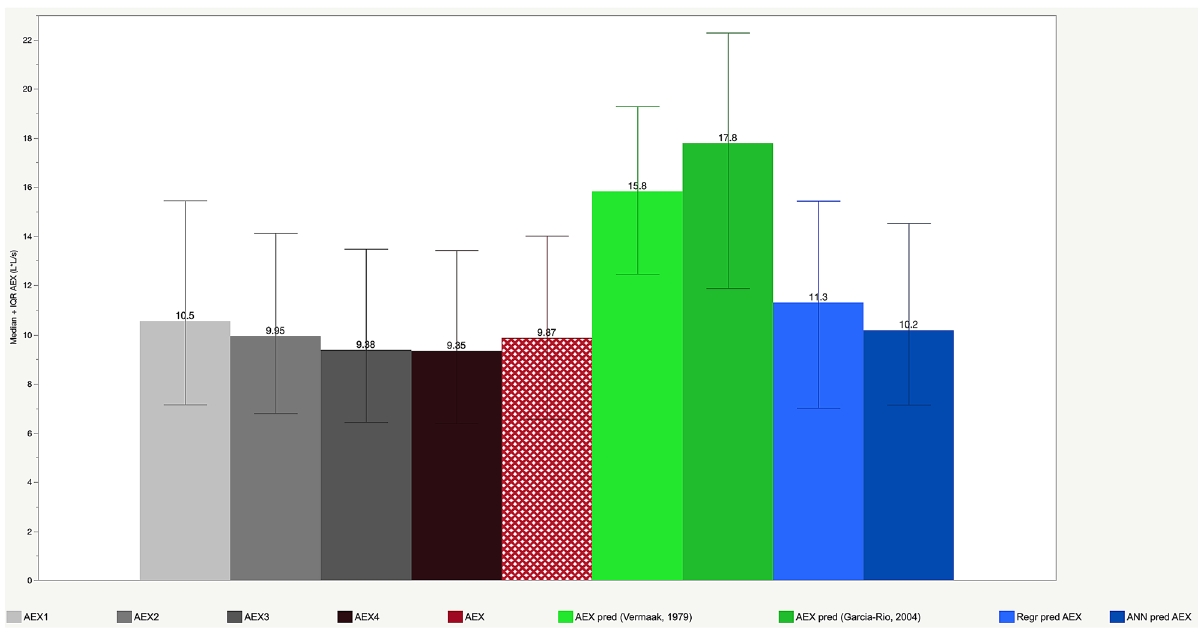
Figure 4. Bar graph showing median values of AEX, AEX 1 through AEX 4 and AEX predicted by three different models (Vermaak et al. 6 ; Garcia-Rio et al. 11 ; and current model, based on artificial neural networks (ANN). Whiskers represent 25th–75th interquartile ranges (IQR).